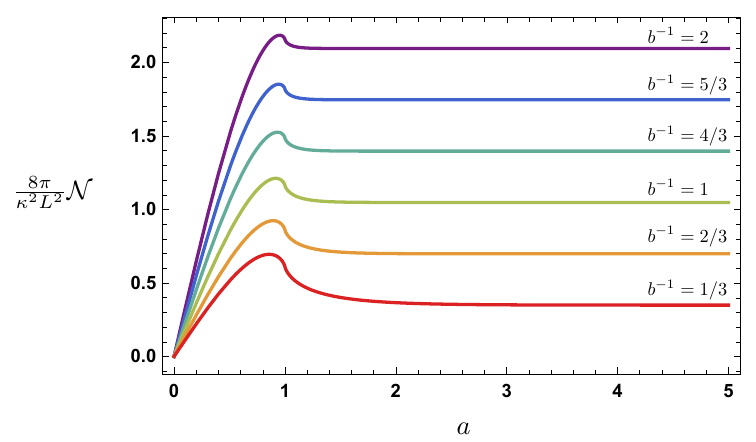
Figure 2 . Noise function from eq. (4.4), written as a function of the rescaled time a = t=L , for N several di(cid:11)erent values of the temperature parameterized by b (cid:0) 1 = TL . The asymptotic decoherence rate, set by the value of at late times, is T N /